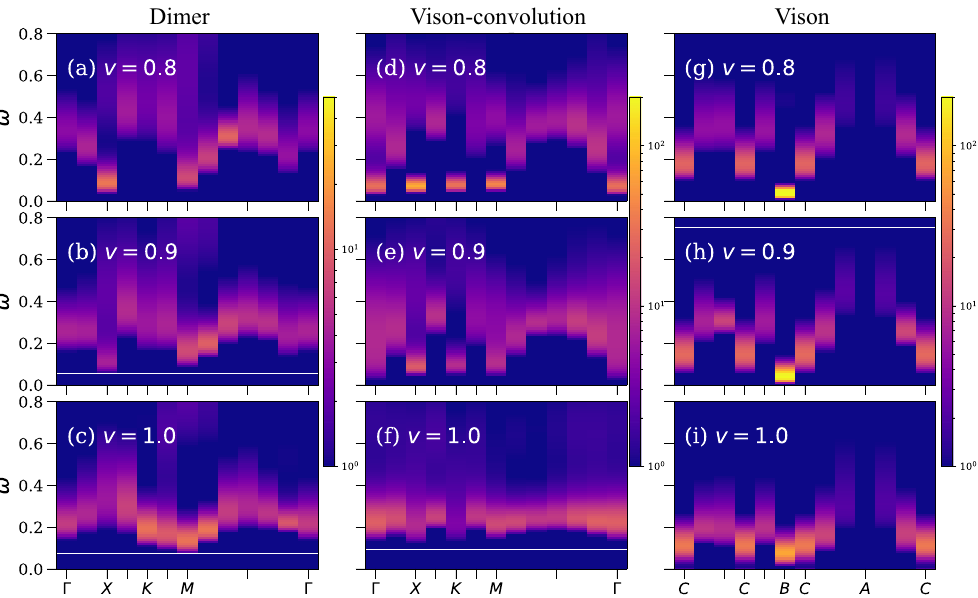
Fig. 2 Spectra of dimer, vison-convolution and vison. Spectra of dimer ( a – c ), vison-convolution ( d – f ) and vison ( g – i ) correlation functions across the VBS-QSL transition. For ( a , d , g ), ( b , e , h ), and ( c , f , i ), V = 0.8, 0.9, and 1, respectively. The results are obtained from L = 12 and β = 200( T = 1/200)